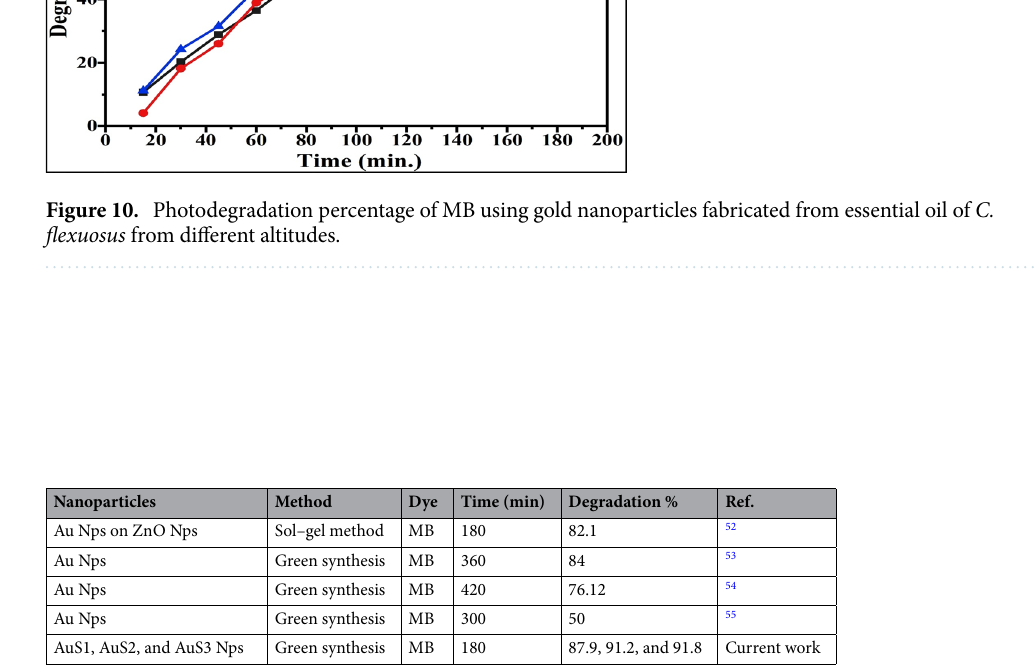
Table 2. Comparative study of gold nanoparticles for photocatalytic performance against MB